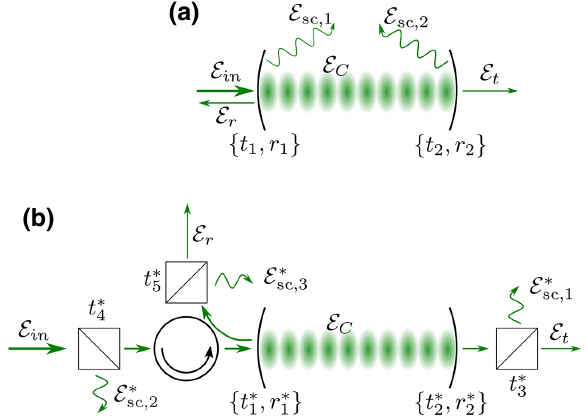
FIG. 12. Analogy between (a) a realistic cavity with loss and (b) an idealized lossless cavity with external loss by using perfect beam splitters and optical